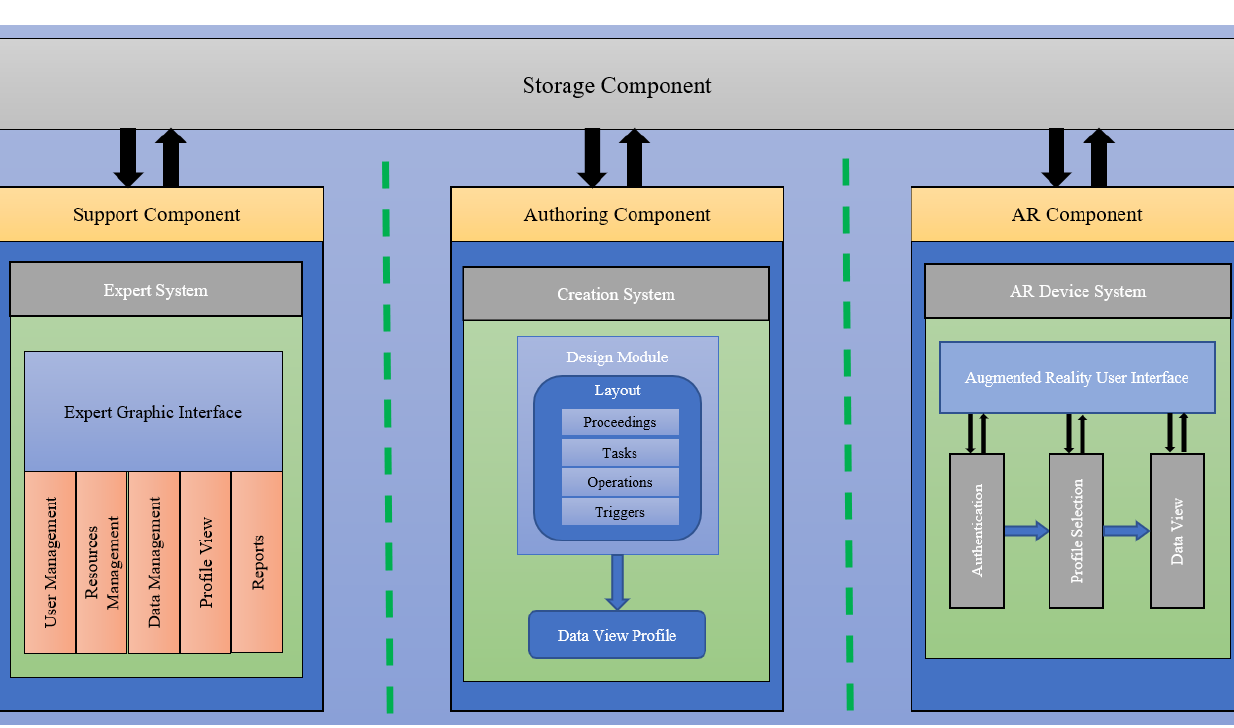
Figure 1. Augmented Reality